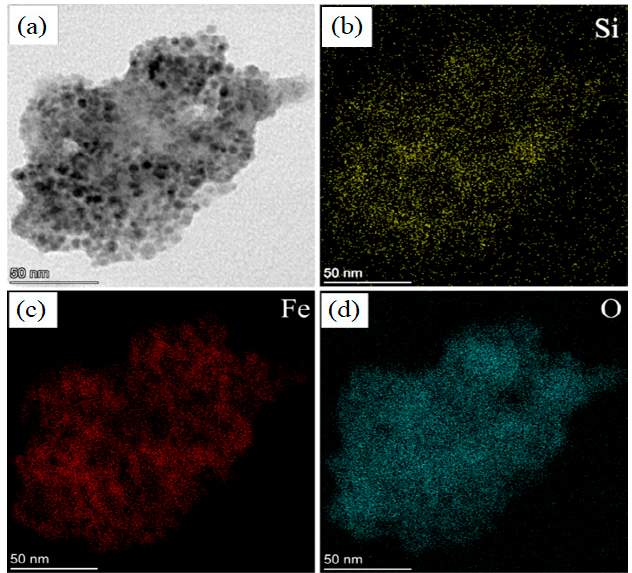
Figure 6. STEM (BF) images of: ( a ) a pSi microparticle after SPIONs decoration at 50 nm scale; elemental mapping of: ( b ) Si; ( c ) Fe; ( d ) O.